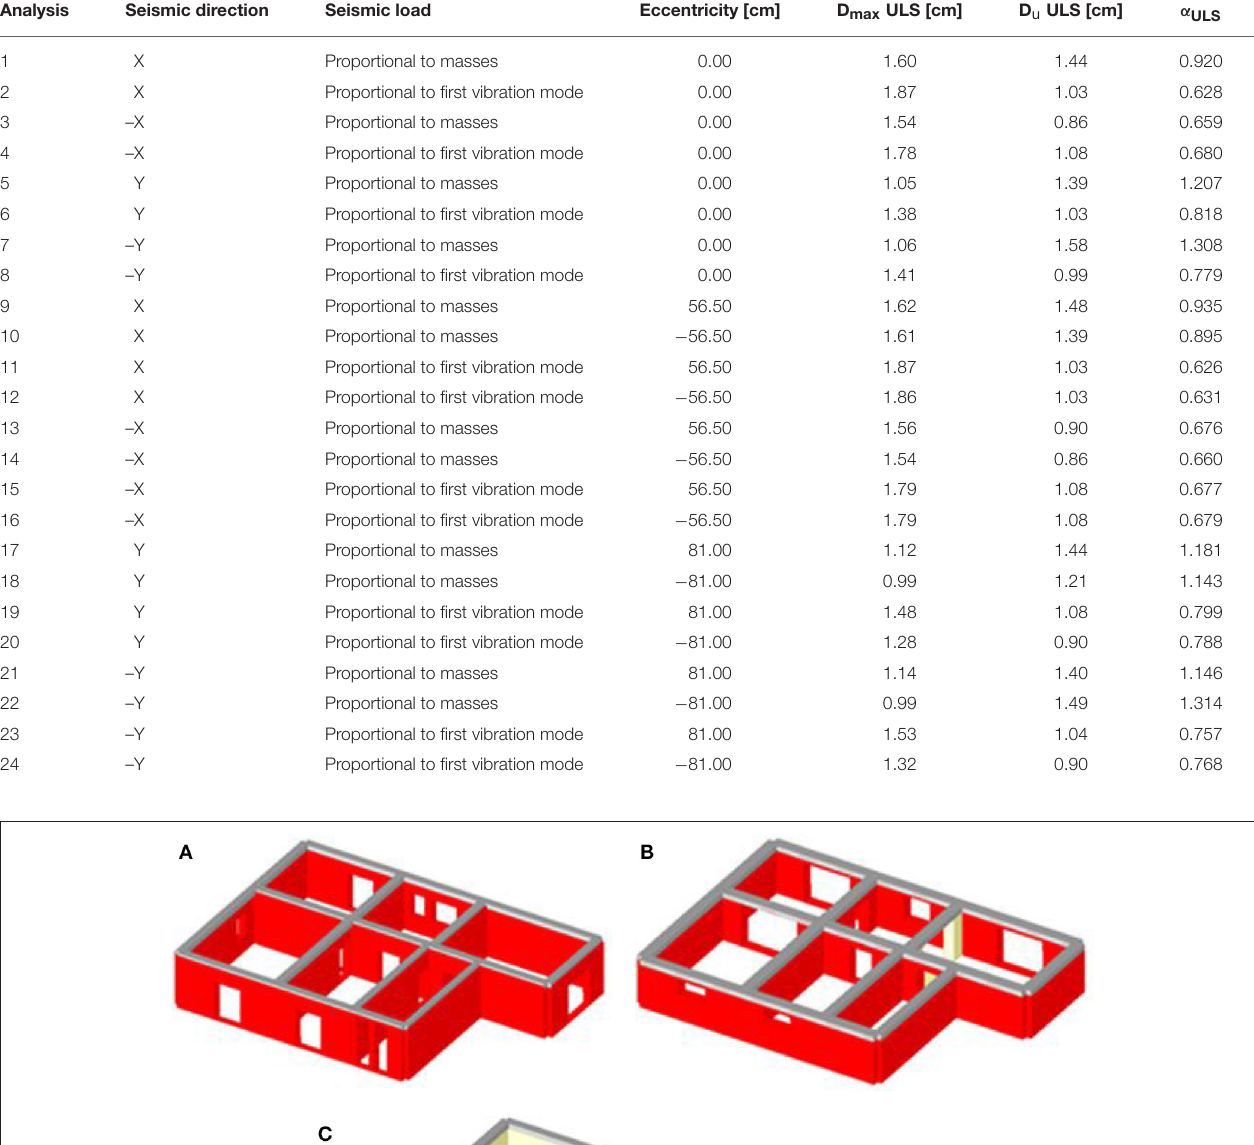
TABLE 2 | Pushover analysis results for seismic upgrading of the URM building.